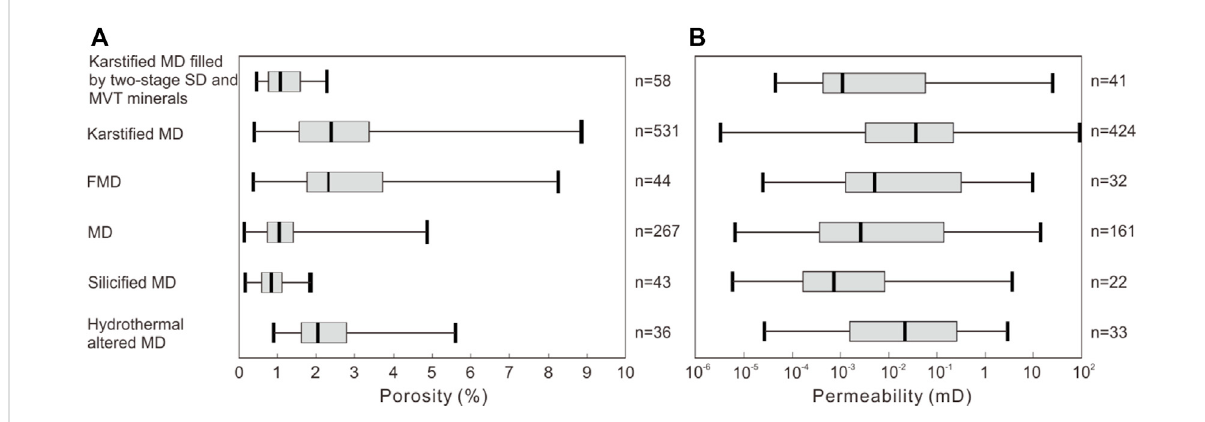
FIGURE 10 (A) Boxplot of porosity distribution in different rock fabrics of the Dengying Formation, Central Sichuan Basin. (B) Boxplot of permeablity distribution in different rock fabrics of the Dengying Formation, Central Sichuan Basin.